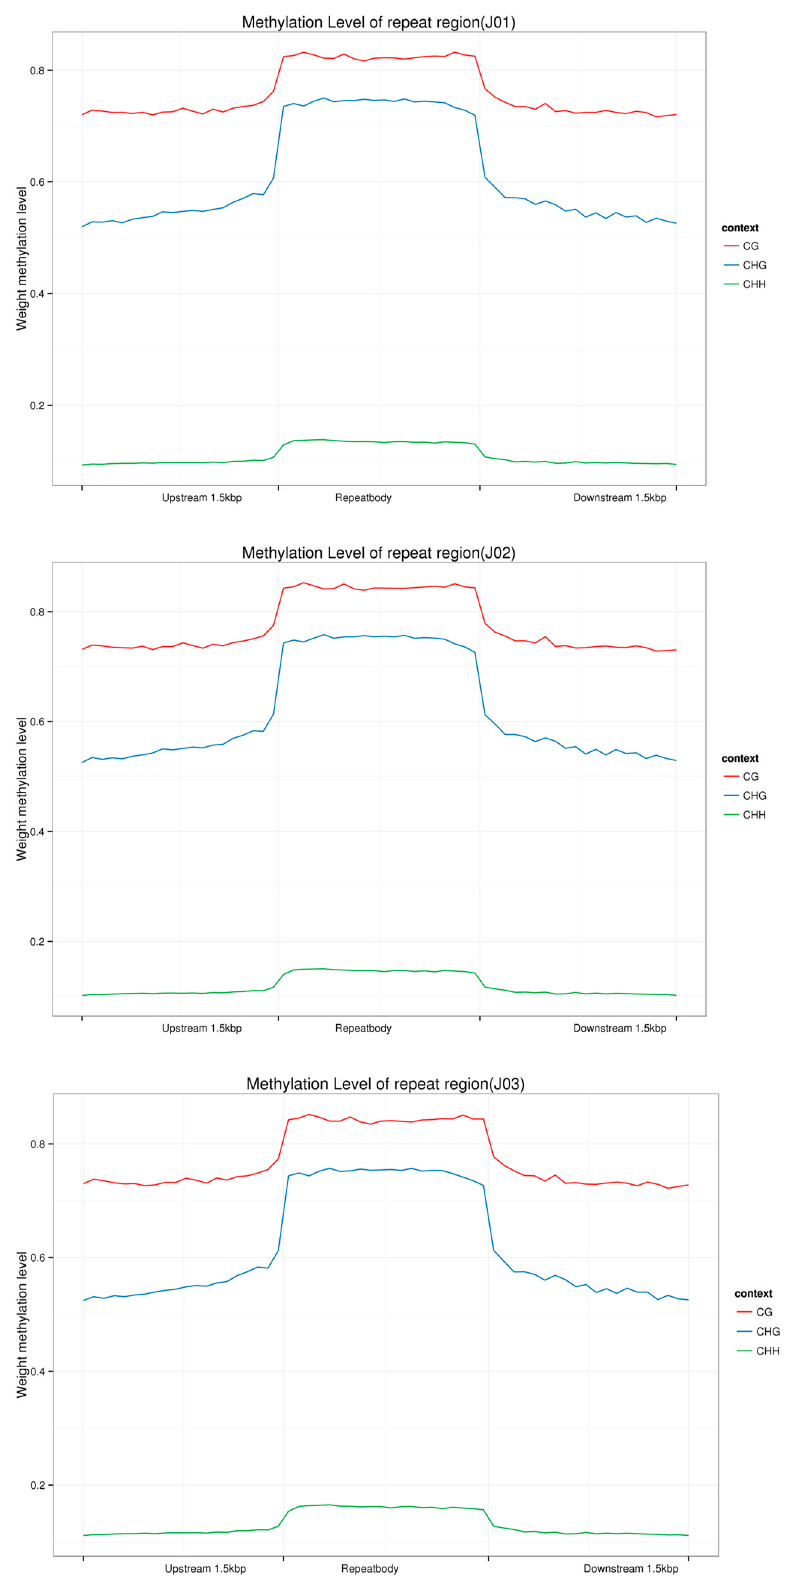
Figure 4. The methylation levels of the repeat regions of different samples. The CG, CHG, and CHH types were first raised and decreased in the downstream region and the methylation levels of the CG and CHG type were considerably higher than the CHH type in the CK (J01), sense (J02), and antisense samples (J03).